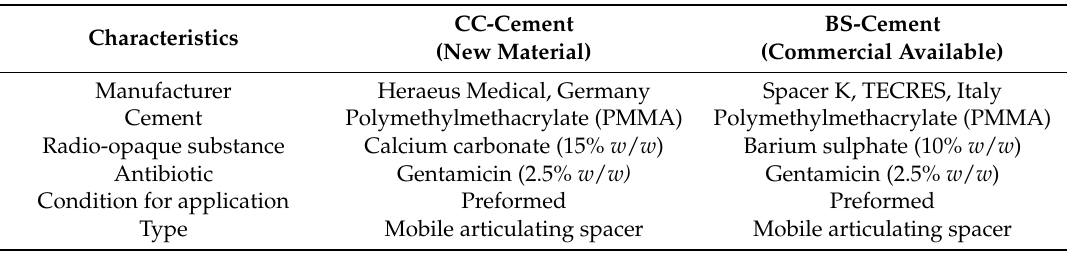
Figure 1. Articulating components of the two cement spacers: BS-cement (left) and CC-cement (right). Table 1. Characteristics of the two investigated spacer cements.